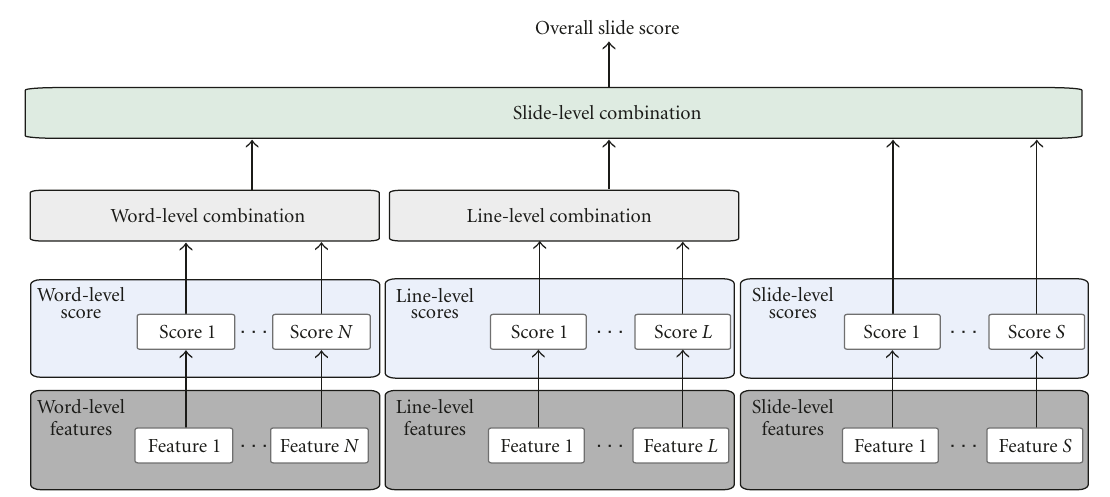
Figure 5: Overview of the relevance calculation model applied to each slide.